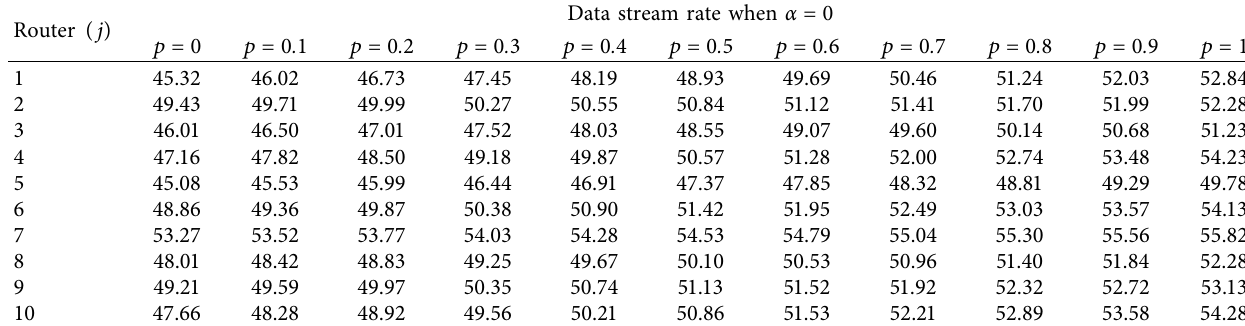
Table 4: Data stream rate for different values of p and α � 0.